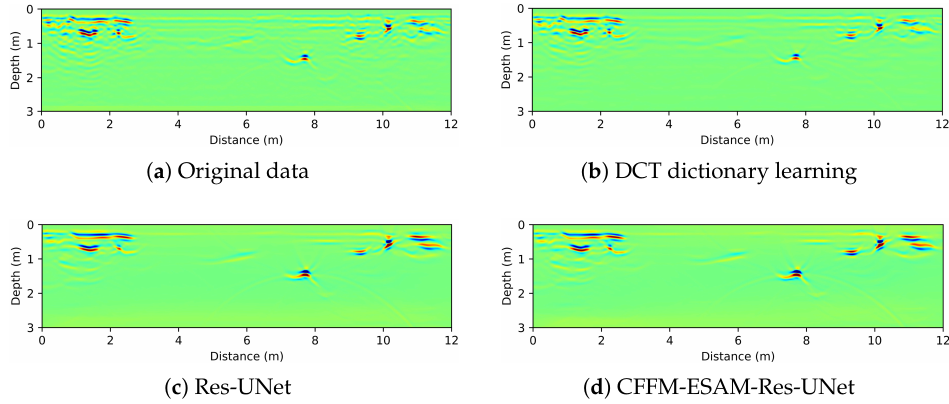
Figure 17. RTM imaging results of field GPR recordings after different processing